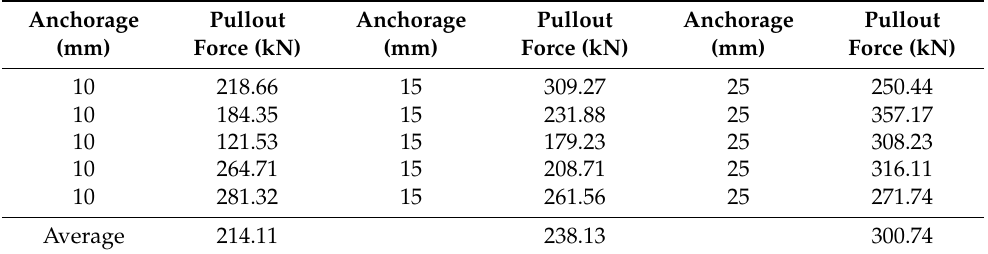
Table 2. Comparison of point cloud mesh to CAD model—cumulated